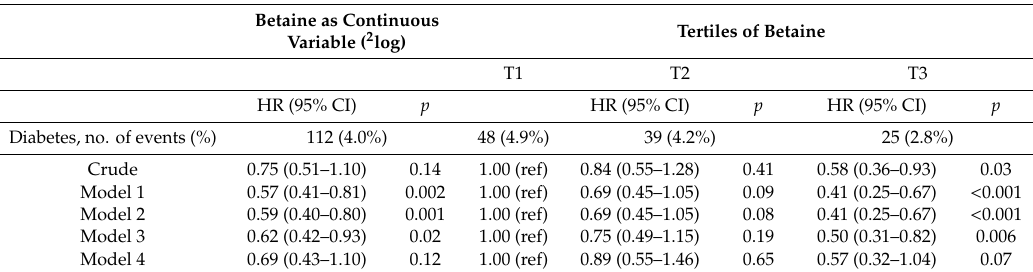
Table 6. Sensitivity analysis of the association of betaine as a continuous variable and according to tertiles with development of T2DM, excluding subjects with previous CVD history, microalbuminuria, eGFR < 60 mL / min / 1.73 m 2 , and use of lipid-lowering drugs. Betaine as Continuous Variable ( 2